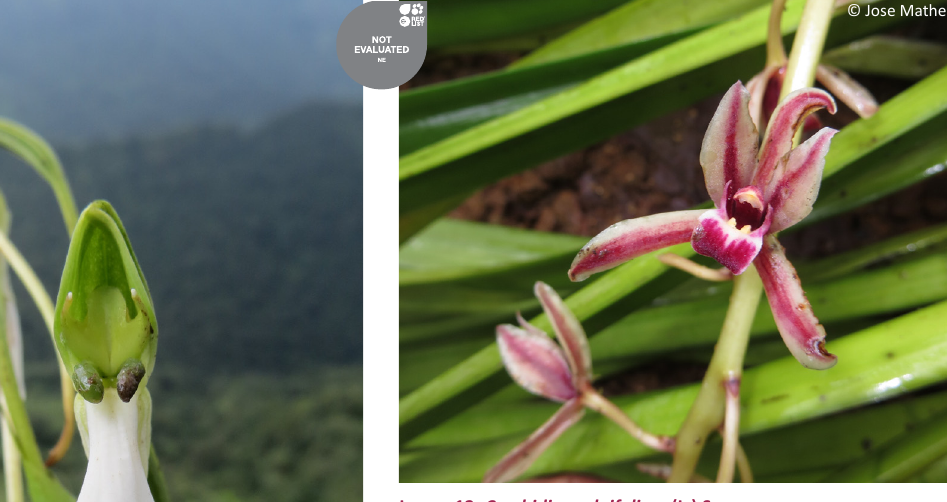
Image 12. Cymbidium aloifolium (L.) Sw.